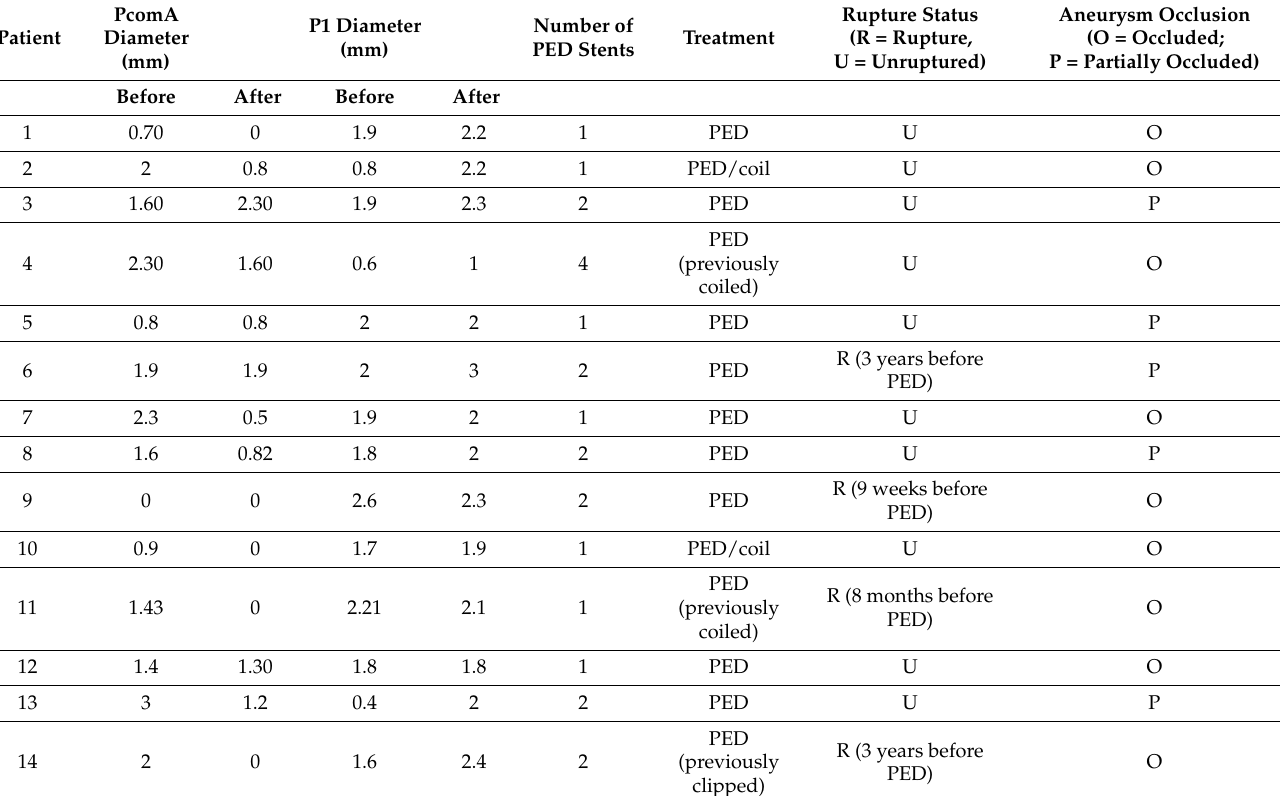
Table 1. PcomA diameter and P1 diameter before and after PED